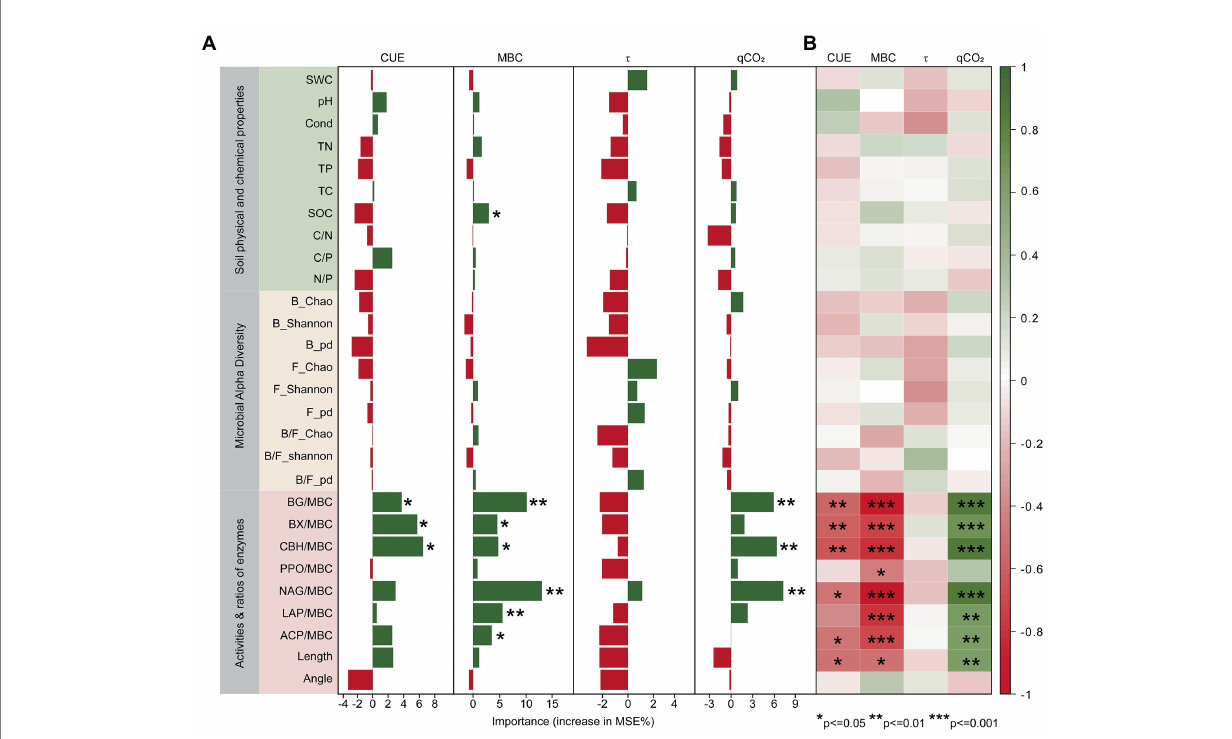
FIGURE 6 Major predictors of microbial metabolic efficiency. (A) Based on the percentage increase in mean squared error (%IncMSE) from the random forest analysis. (B) Spearman correlation analysis of microbial carbon metabolism indicators with selected biotic and abiotic factors. Enzyme/MBC is calculated by normalizing the activity to units/mg MBC and represents the specific enzyme activity. * p < 0.05, ** p < 0.01, *** p <